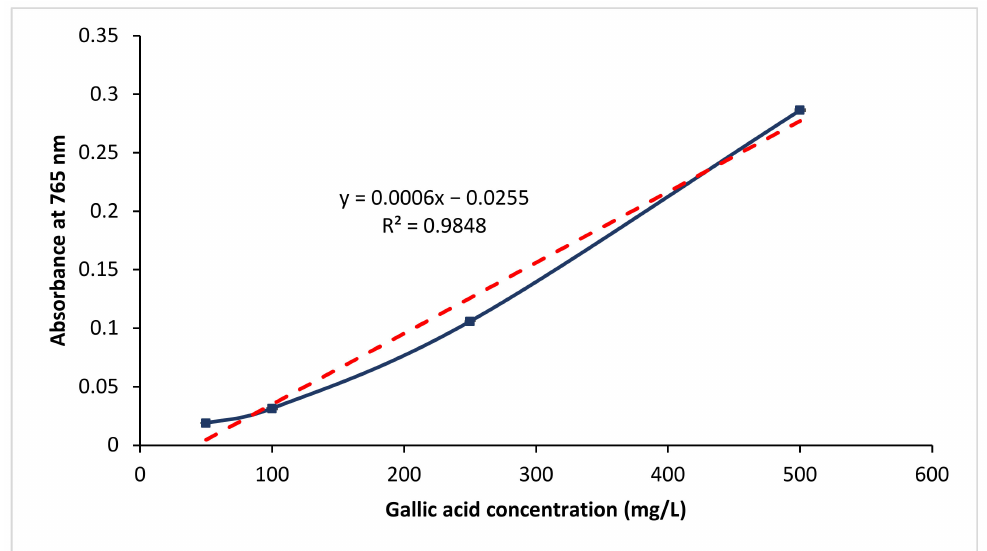
Figure 2. Gallic acid calibration